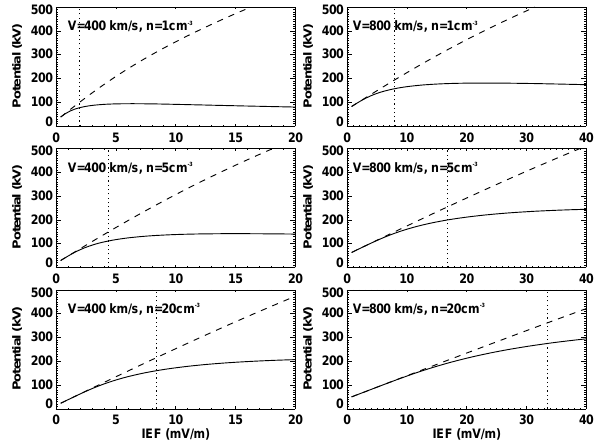
Fig. 10. Examples of CPCP curves as a function of REF using Equation 9 (solid) and Equation 4 (dashed). The left curves use an input solar wind velocity of 400 km/s, while the right curves use 800 km/s. From top to bottom, the input solar wind density is changed from 1 cm − 3 to 5 cm − 3 to 20 cm − 3 . The vertical line indicates when the solar wind Mach number is four. Points to the right are less than four. It should be noted that the vertical scales are the same on all plots, but the left plotsstopat REF = 20 mV/m ,whilethe rightplotsstopat REF = 40 mV/m . TheREF isaltered by changingthemagnitudeoftheIMF B z component-thereisno B y component.